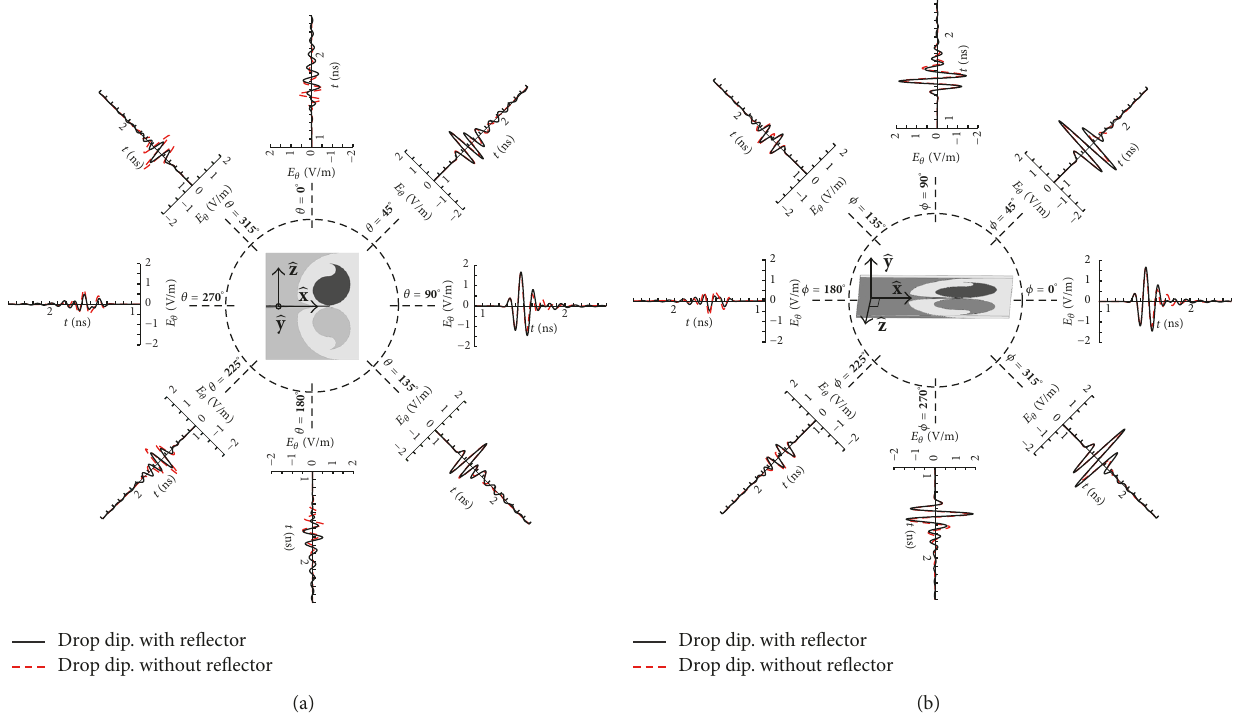
Figure 13: Time-domain behaviour of the electric field radiated by the antenna at a distance of 30 cm from the centre of the dipole arms: (a) in the 𝑥𝑧 -plane and (b) in the 𝑥𝑦 -plane. Characteristics of the excitation signal: 𝜎 = 51 ps. The effect of the reflector is clearly evident in the figure.